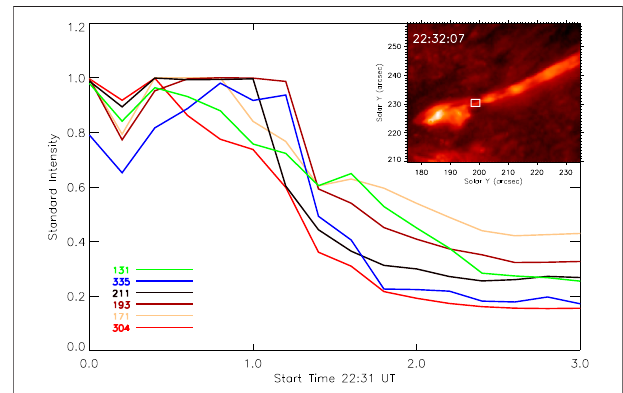
FIGURE9| NormalizedintensityvariationofapartofthejetinPhase2in six different wavelengths (304 Å, 171 Å, 193 Å, 211 Å, 335 Å, 131 Å). Top- right: An image of the jet in Phase 2 with three blobs obtained from SDO/AIA 304 Å at 22:32:07 UT, the white-color box marks the region that we calculate the intensity variation.